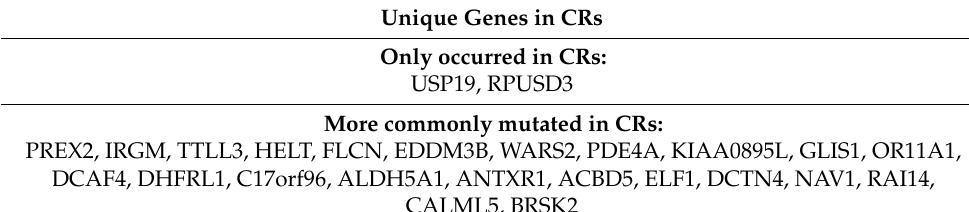
Table 2. List of unique or more frequently mutated genes in CR and NCR